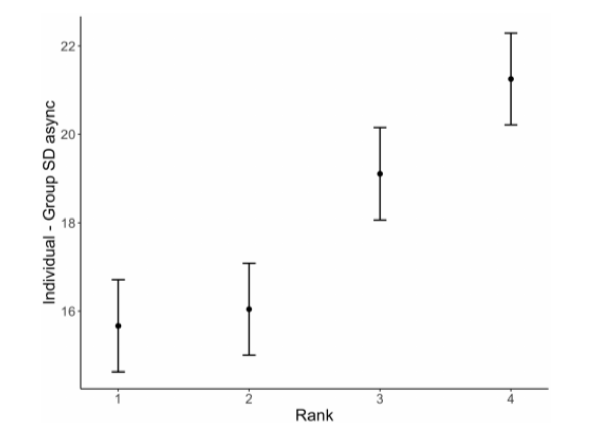
FIGURE 8 | Predicted individual minus group SD asynchrony as a function of individual rank in the group, adjusted for random effects of adaptivity, participant, group, and experiment (see Table 6